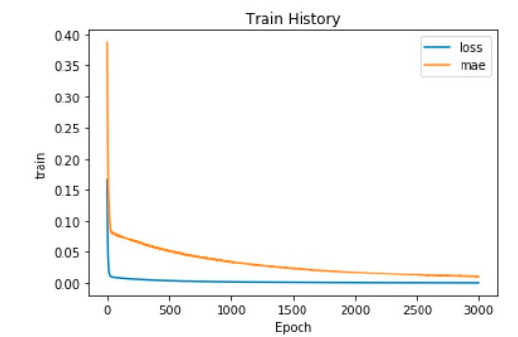
Table 7. 04-Jan-14 Output Set.